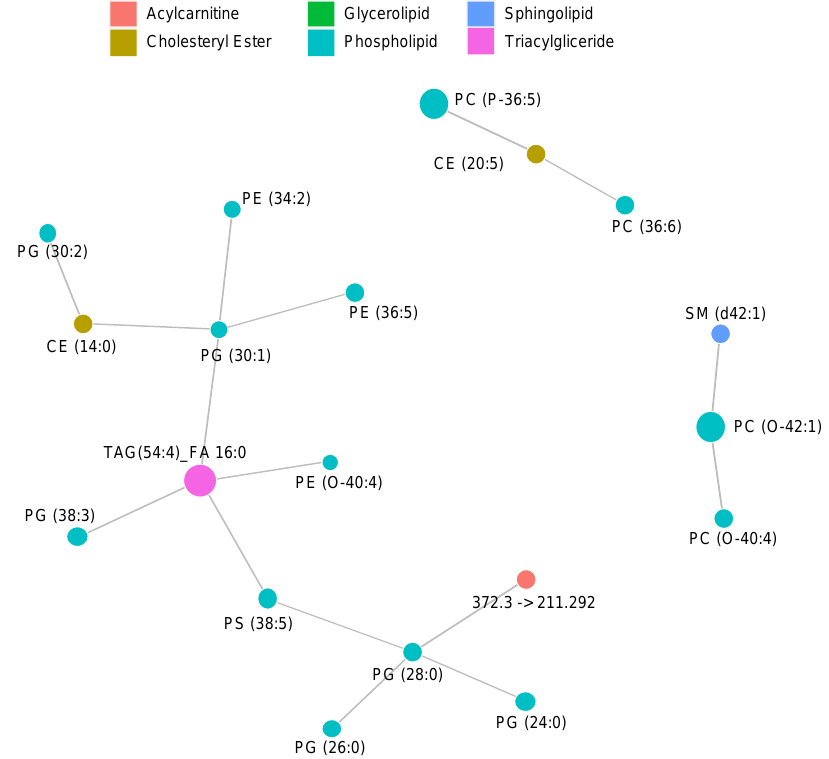
Figure 9. Correlation network demonstrating interdependence between lipid abundances measured in dried blood spot samples.